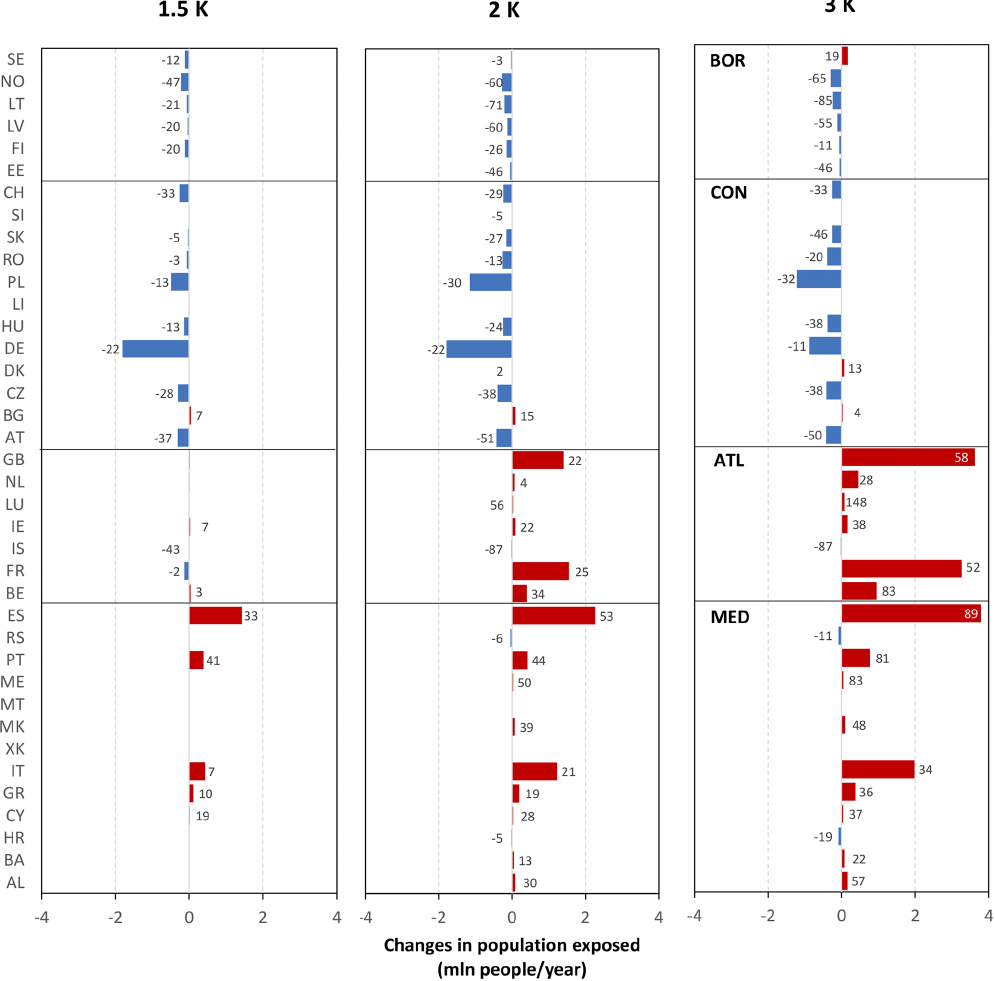
Figure 5. Changes in population exposed per country (million people per year). Positive values indicate an increase in the population ex- posed. The numbers near the bars represent the percentage changes relative to the baseline (only if greater than 1%).